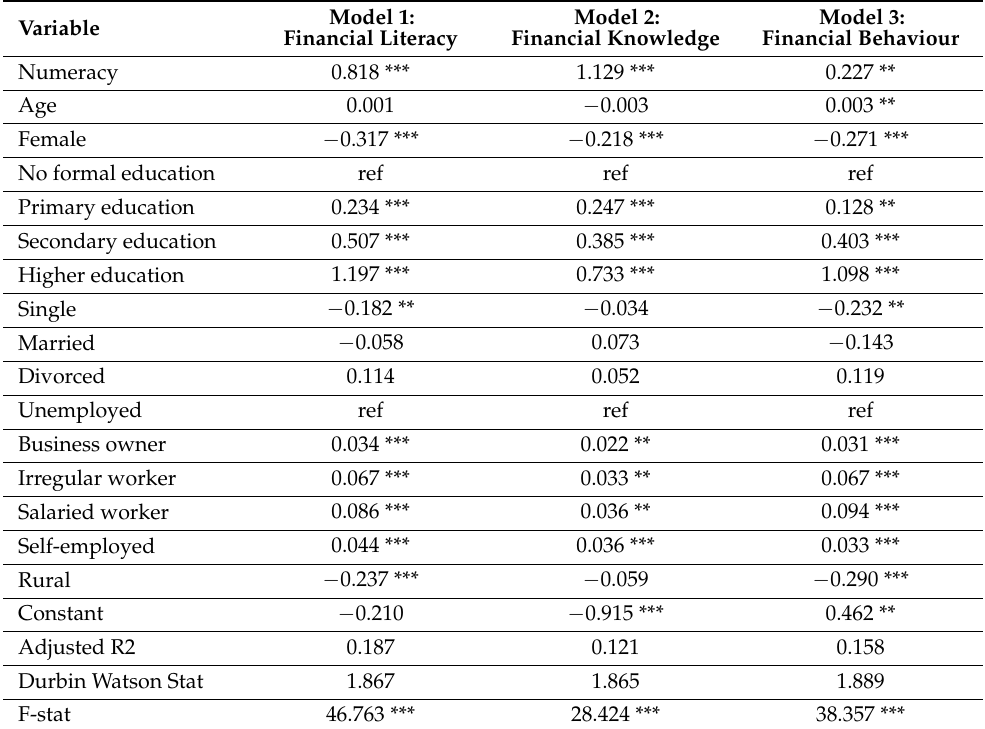
Table 3. Determinants of financial literacy in Tanzania—OLS